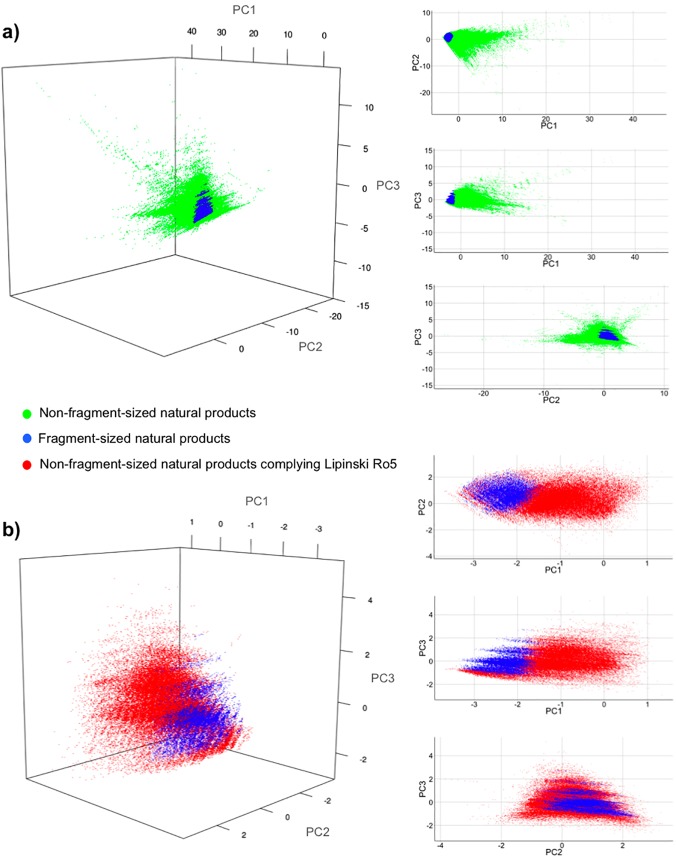
PCA analysis of the DNP.Comparison of fragment-sized natural products to all known natural products (DNP) in physicochemical property space as defined by principal component analysis of 11 physicochemical descriptors. The first three principal components account for 89.0% of the variance in the data (57.6%, 21.2%, and 10.2%, respectively). (a) PCA plot of 165281 clean natural products (145096 non-fragment-sized NPs (green) and 20185 fragment-sized NPs (blue). (b) PCA plot of 94929 natural products (74744 non-fragment sized natural products which satisfy Lipinski’s Ro5 (red) and 20185 fragment-sized NPs (blue)).